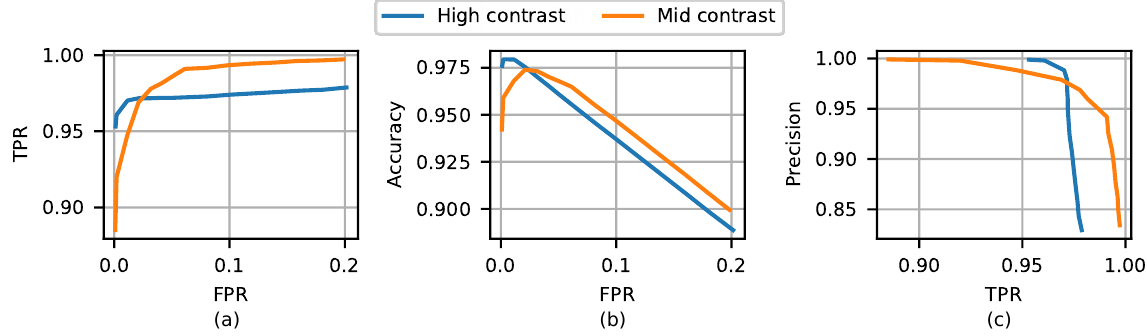
the SNI perturbation dataset.